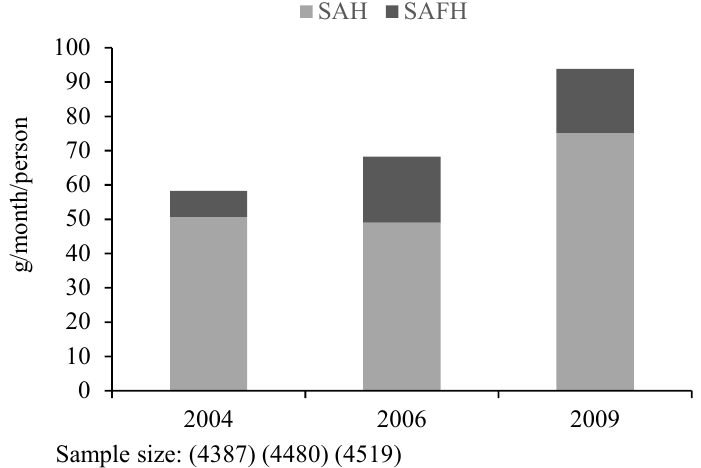
Figure 1. Chinese residents’ seaweed consumption.